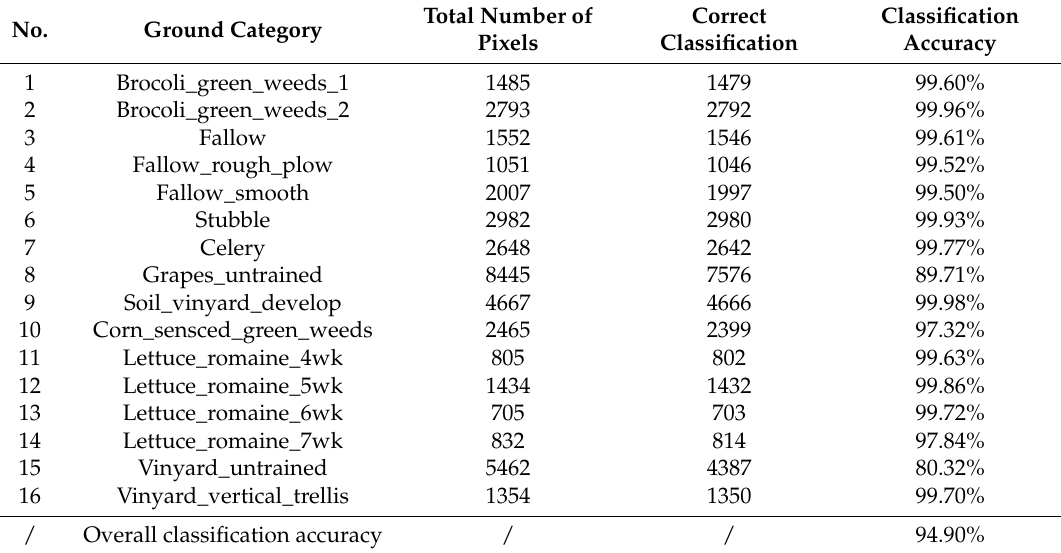
Table 14. Statistical tables for maximum overlap pooling CNN classification charting accuracy used Salinas